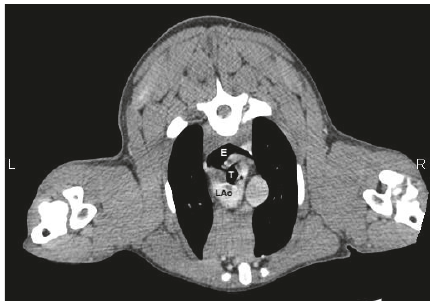
Figure 2: Post-contrast computed tomography (CT) angiogram with contrast showing compression of the trachea(T) by the smaller aberrant right aortic arch (black asterisk) and esophageal dilation (E). Note also the origin of the left aortic arch in the normal position